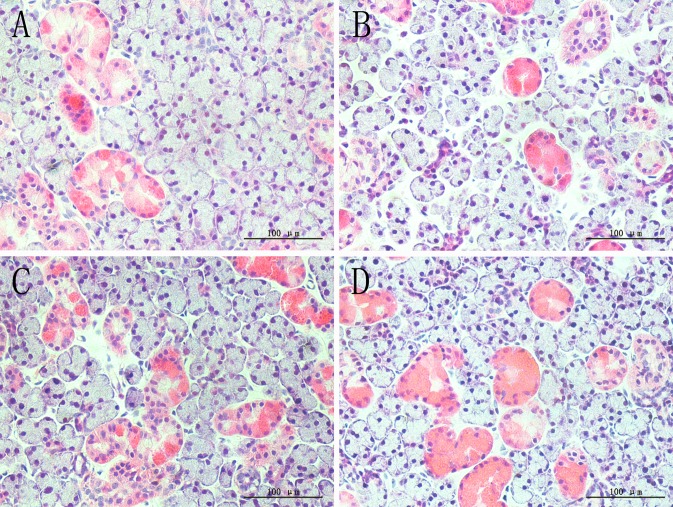
H&E staining of submandibular gland.A, SHAM; B, OVX; C, OVX + E; D, OVX + iCR. All scale bars represent 100 μm (magnification ×400). Coincidence with the lacrimal gland, sparse acinar cells and increased intercellular space was commonly seen in the OVX group, while both of the treatment can improve the condition of ovariectomy-induced lesions.